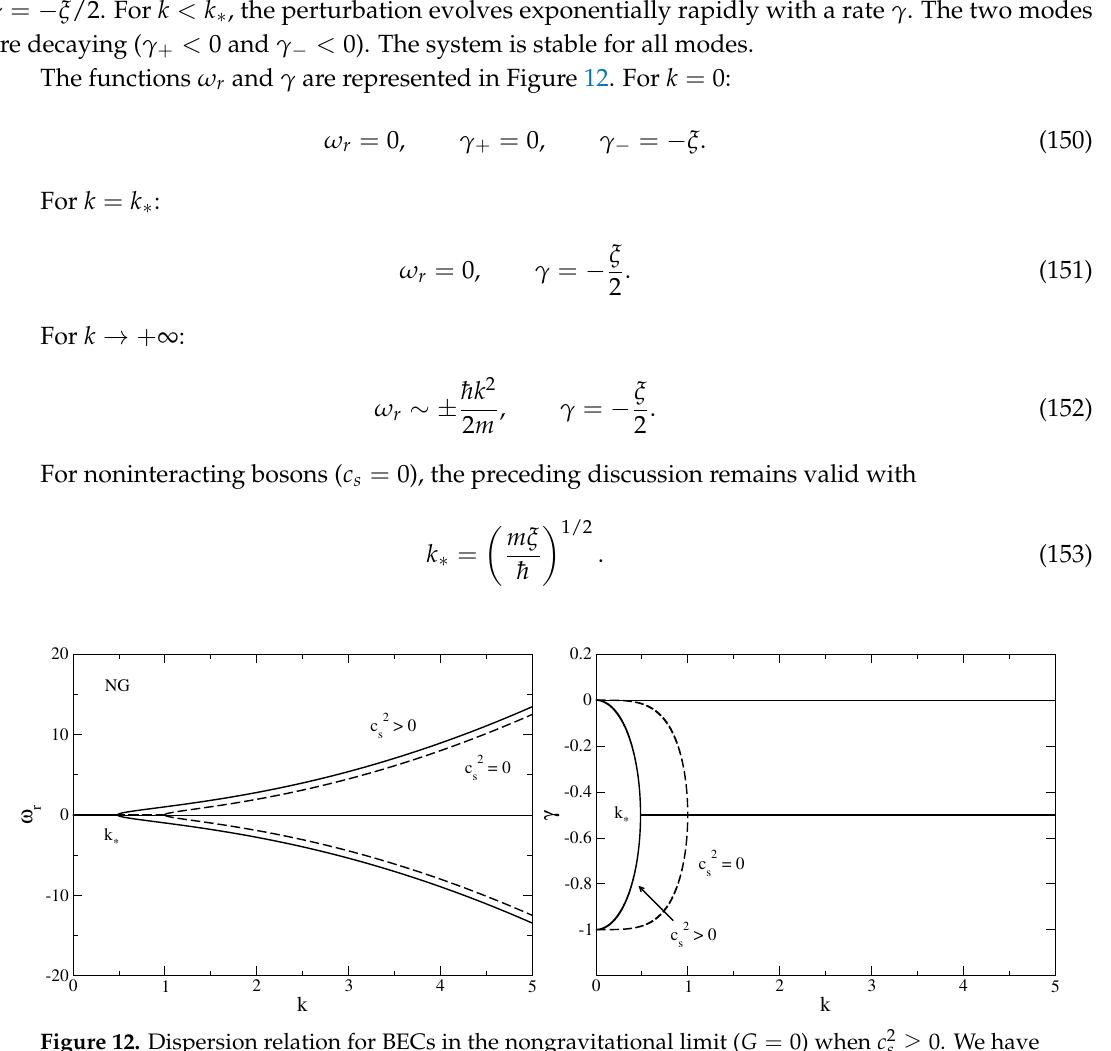
Figure 12. Dispersion relation for BECs in the nongravitational limit ( G = 0) when c 2 s ≥ 0. We have normalized the wavenumber by mc s /¯ h and the pulsation and the friction by mc 2 s /¯ h . This is equivalent to taking m = c s = ¯ h = 1 in the dimensional equations. We have selected ξ = 1. When c s = 0, we can normalize the pulsation by ξ and the wavenumber by ( ξ m /¯ h ) 1/2